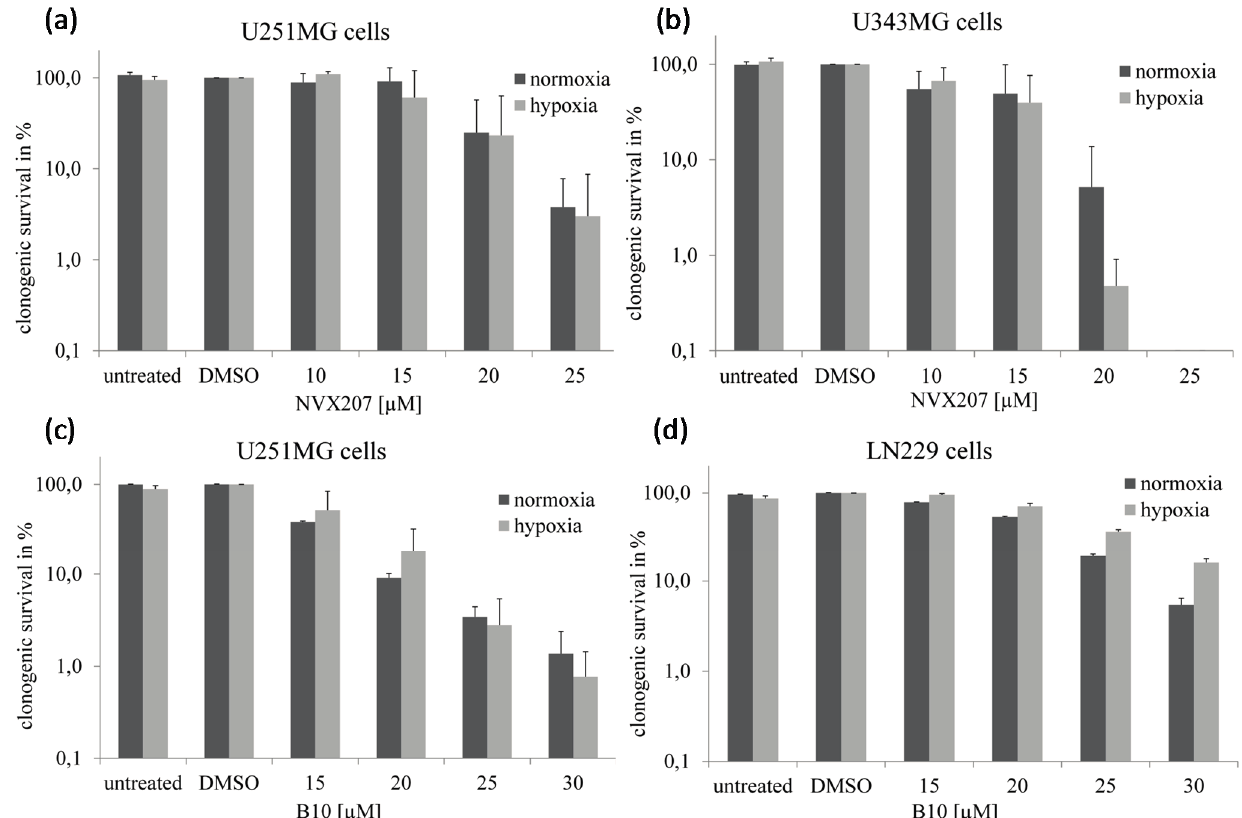
Figure 3. Effects of NVX-207 and B10 on the clonogenic survival of glioma cells. Clonogenic survival of glioma cells after treatment with NVX-207 or B10 for 24 h under normoxic or hypoxic conditions. Under hypoxia, NVX-207 ( a , b ) and B10 ( c , d ) did not show decreased clonogenic survival in glioma cell lines compared to normoxic conditions. The data represent the mean values (±SD) of three independent